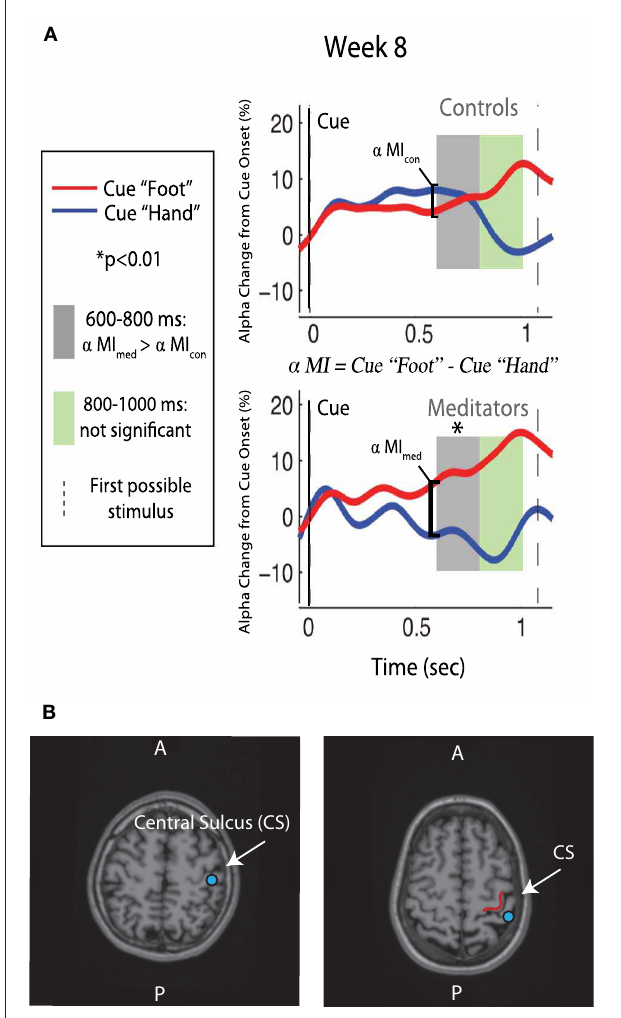
FIGURE 3 | Alpha modulation and ST-Mindfulness training. (A) Compared to non-meditators, ST-Mindfulness subjects’ exhibit greater alpha differentiation between attend-hand vs. attend-foot conditions in the early post-cue period [600–800ms, indicated by shaded region; originally published in Kerr et al. (2011a,b). Permission to use figure received from Brain Research Bulletin ]. (B) From two participants, illustration of SI localization, with equivalent current dipole (blue dots) overlaid on MRI brain structure images proximal to the omega shape in the anterior bank of the post-central